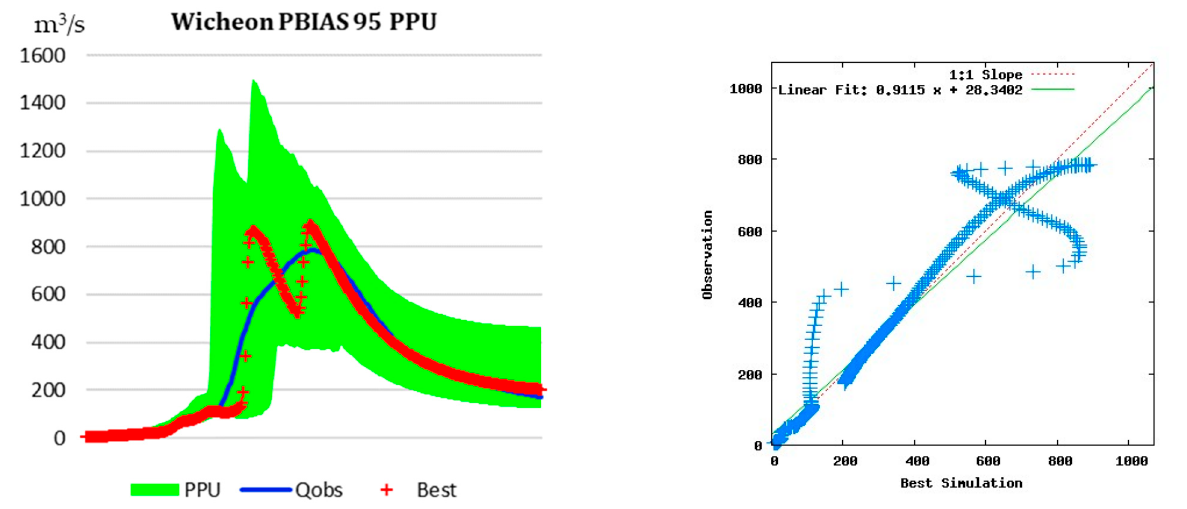
Figure 10. PBIAS 95 PPU for uncertainty of L 2 -based behavior model.